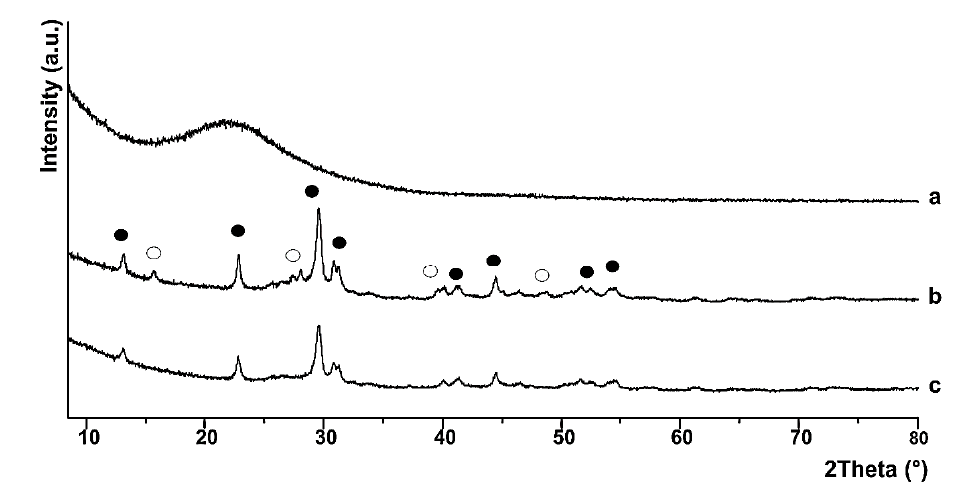
Figure5. PowderX-raydi ff raction(PXRD)spectraforKIT-6( a ), La(III)O-KIT-6( 2 )( b ), andLa(III)O-KIT-6 after III cycle ( 2 (cid:48) ) ( c ). Full circles denote La 2 O 2 CO 3 and empty circles denote La(OH) 3 . Figure 5. Powder X-ray diffraction (PXRD) spectra for KIT-6 ( a ), La(III)O-KIT-6 ( 2 ) ( b ), and La(III)O- KIT-6 after III cycle ( 2 ′ ) ( c ). Full circles denote La 2 O 2 CO 3 and empty circles denote La(OH) 3 .